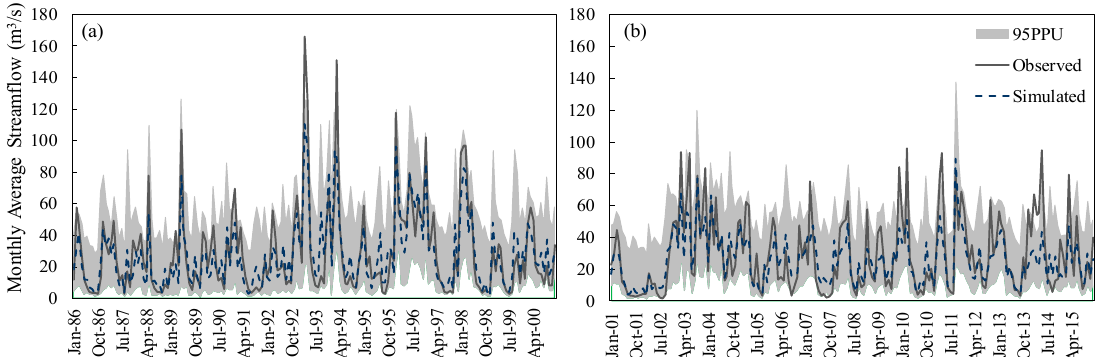
Figure3. Hydrographsshowingthecomparisonofobservedandsimulatedaveragemonthlystreamflow Figure 3. Hydrographs showing the comparison of observed and simulated average monthly streamflow during ( a ) calibration (1986–2000) and ( b ) validation (2001–2015) period at the outlet of the Monocacy River Watershed.